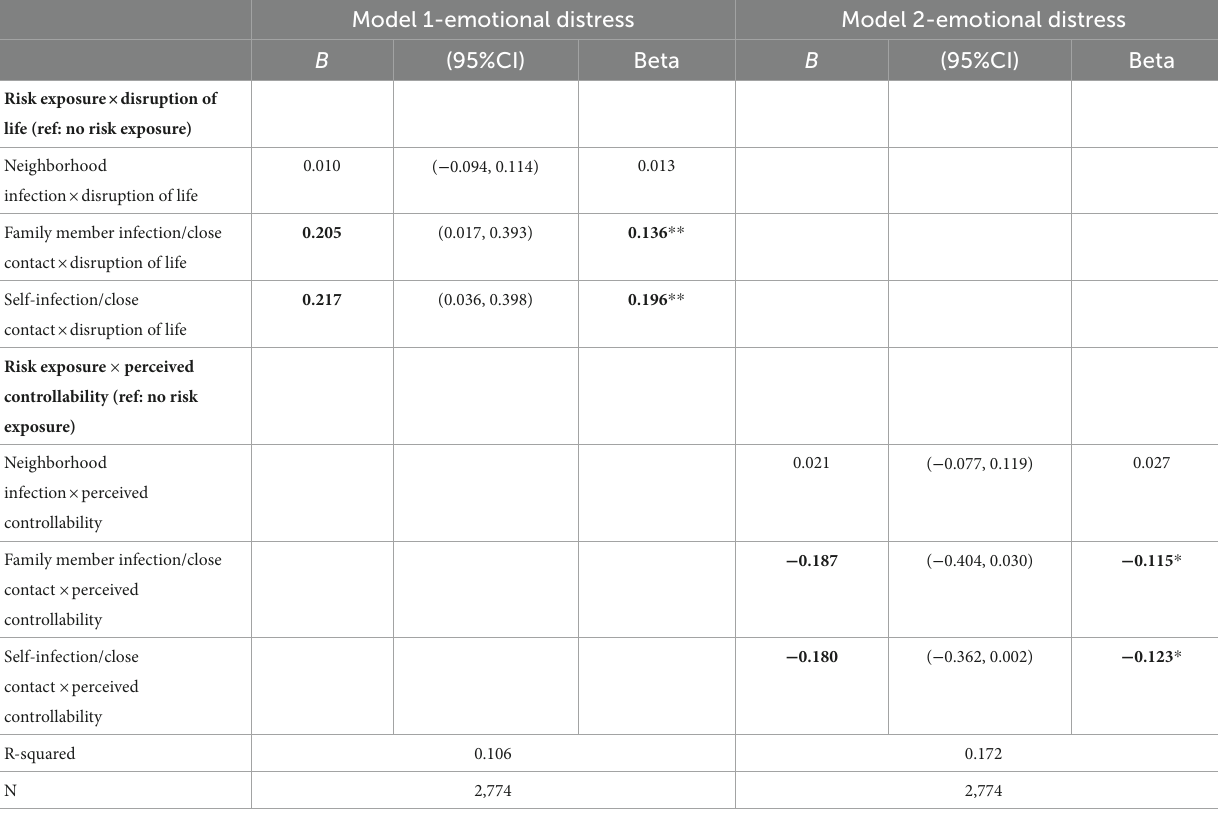
TABLE 3 Multiple linear regression analysis for interaction effects of risk exposure and disruption of life on emotional distress and risk exposure and perceived controllability on emotional